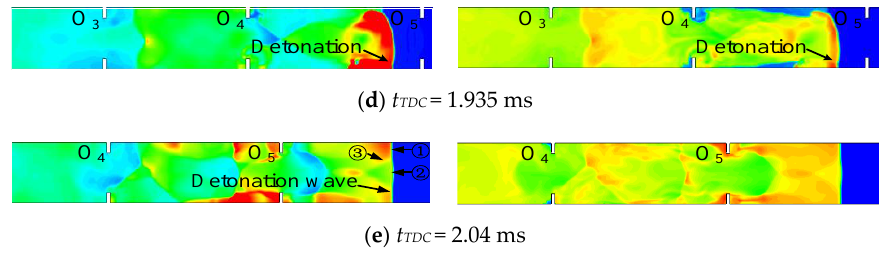
Figure 9. Variations of pressure and temperature field at detonation transition (DDT).